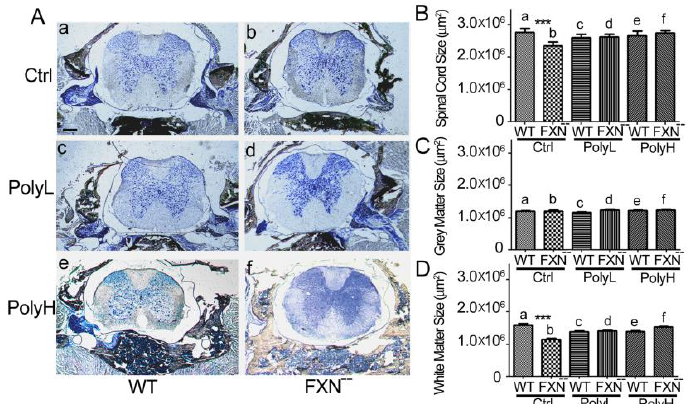
Figure 3. ( A ): Cervical spinal cord phenotype of 6 months-old mice in the absence (Ctrl, a,b) or in the presence of either low (PolyL, 0.0185 mg / gram of food, c,d) or, respectively, high (PolyH, 0.185 mg / gram of food, e,f) EGCG concentrations. The phenotype is reported of toluidine blue-stained spinal cord sections from either WT (a,c,e) and FXN – mutant (b,d,f) mice. ( B – D ): Results of the morphometric analysis of the spinal cord size in the conditions shown in ( A ). ( B )– D report on the analysis of sections from the whole spinal cord ( B ), or from its grey ( C ) and white ( D ) matters, respectively. An e ff ect of the mutation in terms of the corresponding section area surfaces was demonstrated on the whole spinal cord (15.5% decrease, ( B ) a,b) as well as on the white matter (28% decrease, D a,b) of FXN – mutant mice versus WT littermates, consistent with the occurrence of fibers atrophy. This phenotype could be e ffi ciently counteracted by low (PolyL: ( B ), D c,d) as well as high (PolyH: ( B ), D e,f) conditions of EGCG administration in the food. On the other hand, hardly detecF e ff ects were observed in the grey matter ( C ), confirming that the observed overall spinal cord phenotype should be mostly attributed to an e ff ect on fibers growth rather than on perikarya. A p -value < 0.0001, indicated by ***, was considered statistically significant. Scale bar: 200 µ m.